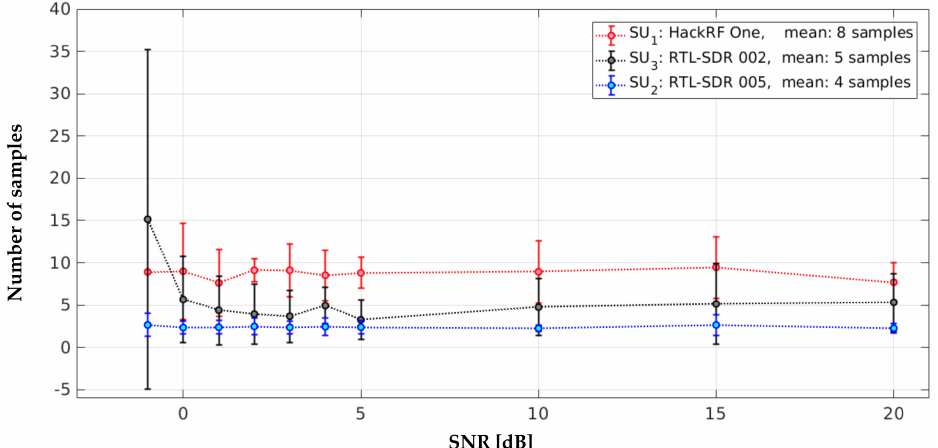
Figure 22. Samples in error for each SU in the